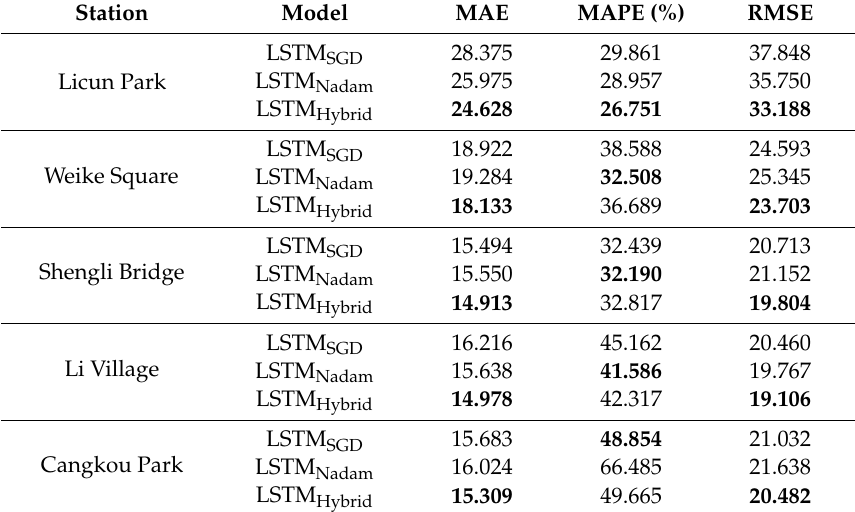
Table 8. Comparison results of di ff erent